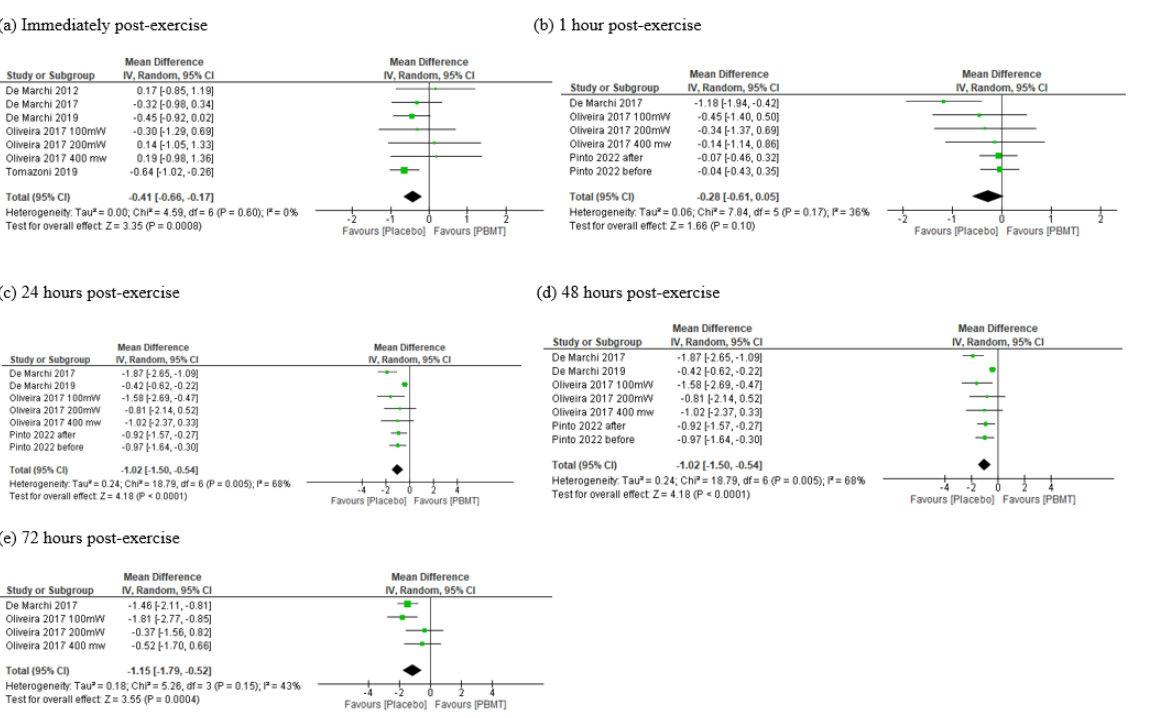
Figure 5. Meta-analysis of damage to proteins immediately post exercise ( a ) and 1 h ( b ), 24 h ( c ), 48 h ( d ) and 72 h ( e ) post exercise. PBMT — photobiomodulation, IV — inverse variance, CI — confidence interval. and 72 h ( e ) post exercise. PBMT—photobiomodulation, IV—inverse variance, CI—confidence